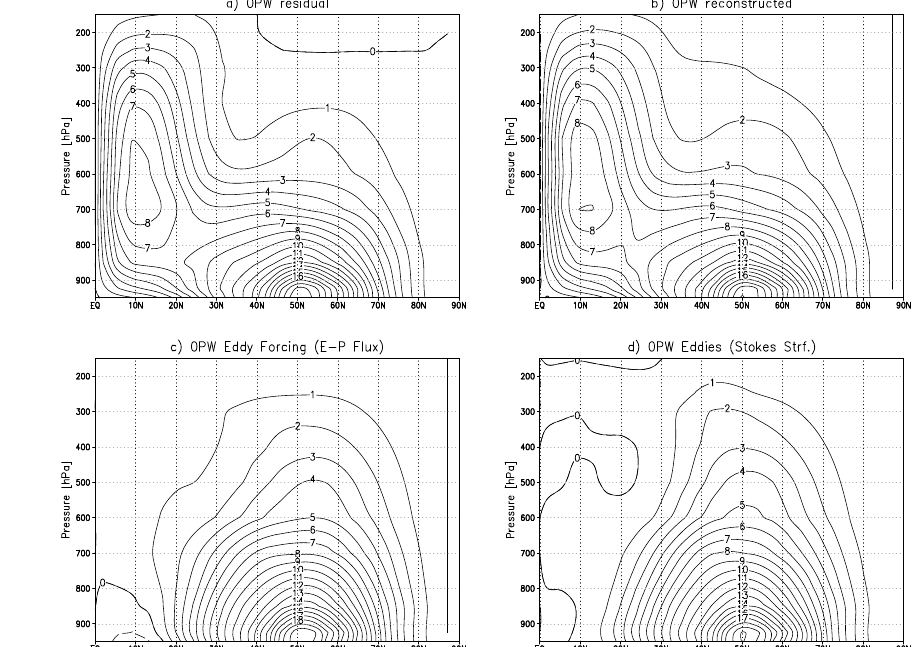
Figure 16. Climatological annual mean residual stream function (in 10 10 kgs − 1 ) for OHT max = 0PW: (a) original; (b) reconstructed; (c) eddy source; (d)